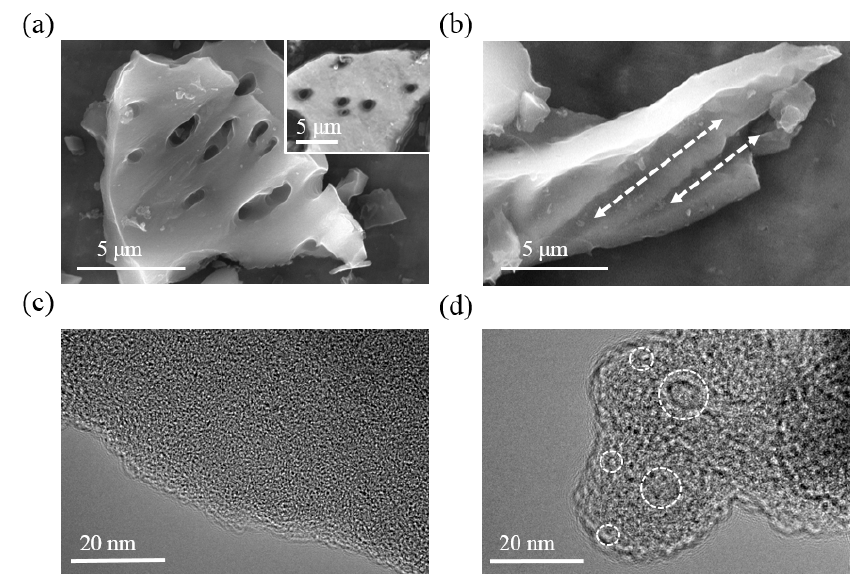
Figure 2. SEM images of pyrolyzed-activated carbon ( a ) macropores and ( b ) channels inherited from natural corncob materials, TEM images of corncob-derived carbon materials ( c ) before and ( d ) after activation, inset of ( a ) is the SEM image of natural corncob.